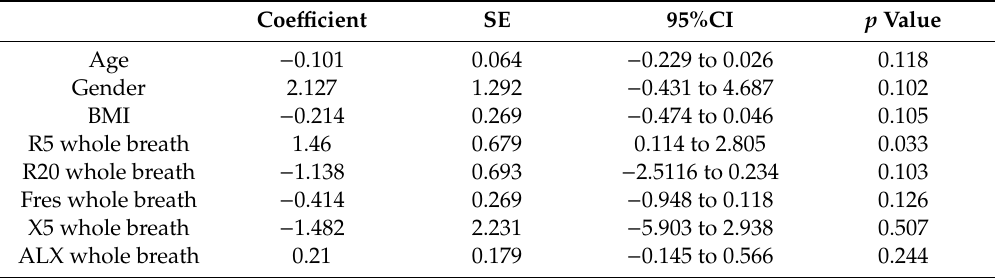
Table 4. Multiple linear regression analysis of clinical variables associated with hypercapnia.